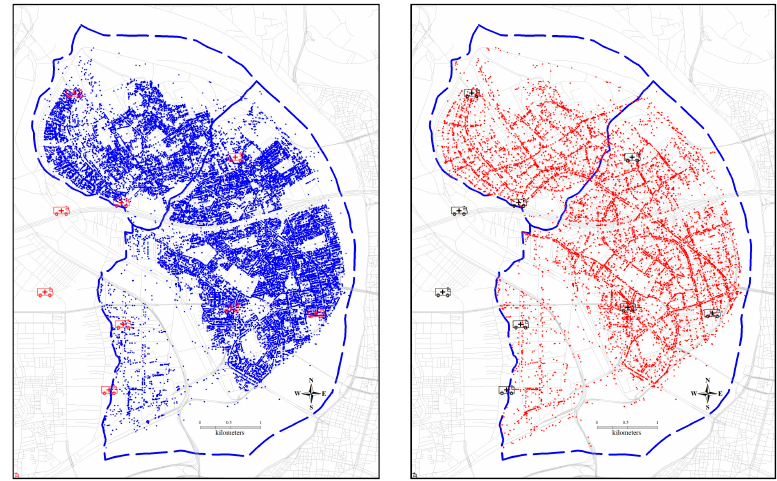
Figure 3. Nontra ffi c-related emergency medical services (EMS) ( left ) and tra ffi c-related EMS ( right ) incidents for Sanchong and Luzhou Figure 3. Nontraffic-related emergency medical services (EMS) (left) and traffic-related EMS (right) incidents for Sanchong and Luzhou districts.